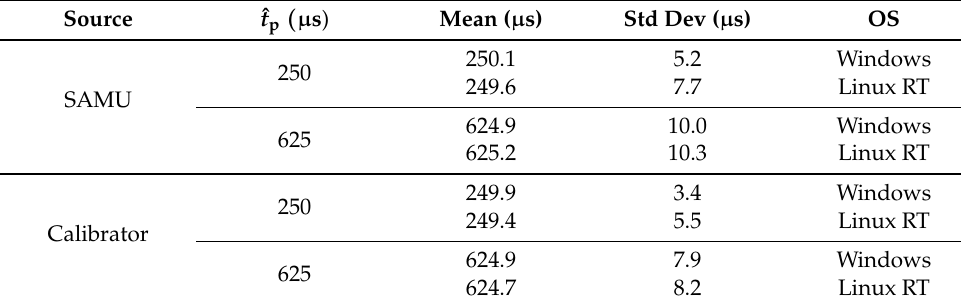
Figure 9. Probability distributions of the SAMU (blue bars) and the IEC Std calibrator (red bars) publishing period for SV data streams with nominal values: ( a ) 250 and ( b ) 625 µ s. The bin width is 1 µ s. Table 3. Probability Distribution Functions-Statistical